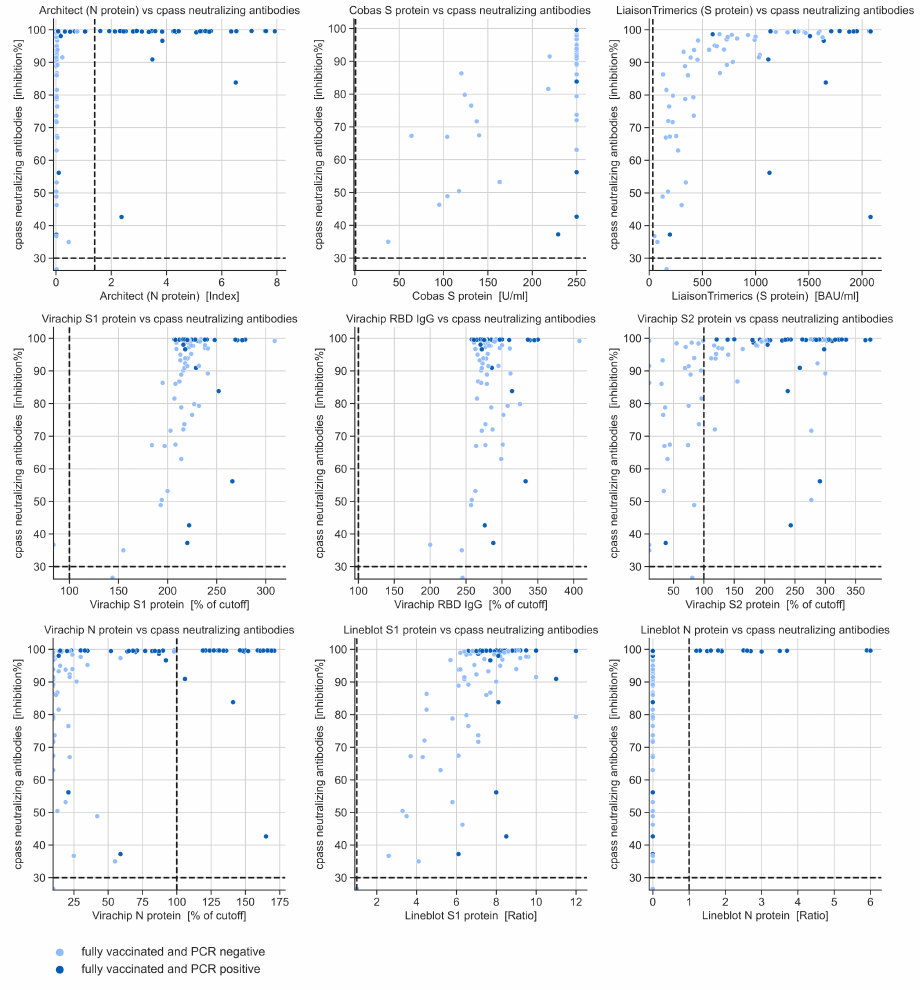
Figure A1. Relationship between measurement values for each assay with cPass neutralizing anti- bodies. Dashed line represents cut-off value. Corresponding Spearman Rank correlation coefficients are summarized in Table